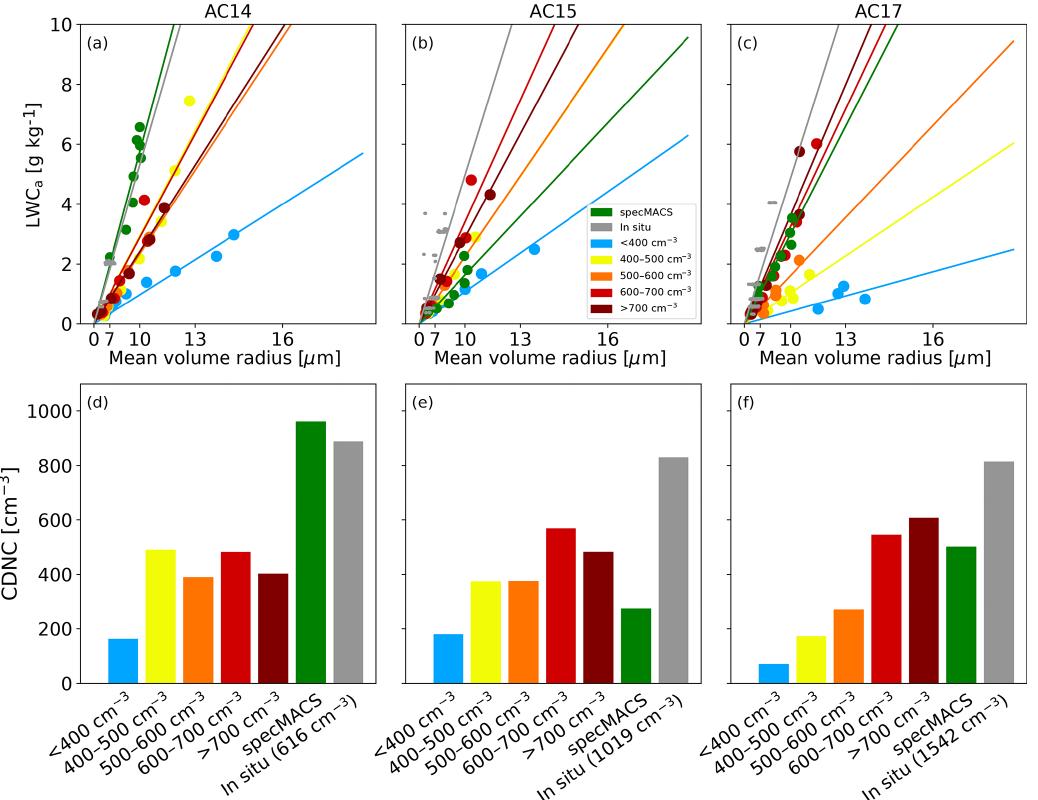
Figure 6. Derived cloud droplet number concentration (CDNC) on 3d during the field campaign. (a–c) show the regressions between mean volume radius and adiabatic liquid water content (LWC a ) used to derive the CDNC as shown in (d–f) . Average in situ CCN concentrations below 2km are shown below the in situ-derived N a . (d–f) CDNC was derived from the slopes in (a–c) , whereas Fig. 5d–f CDNC was more directly